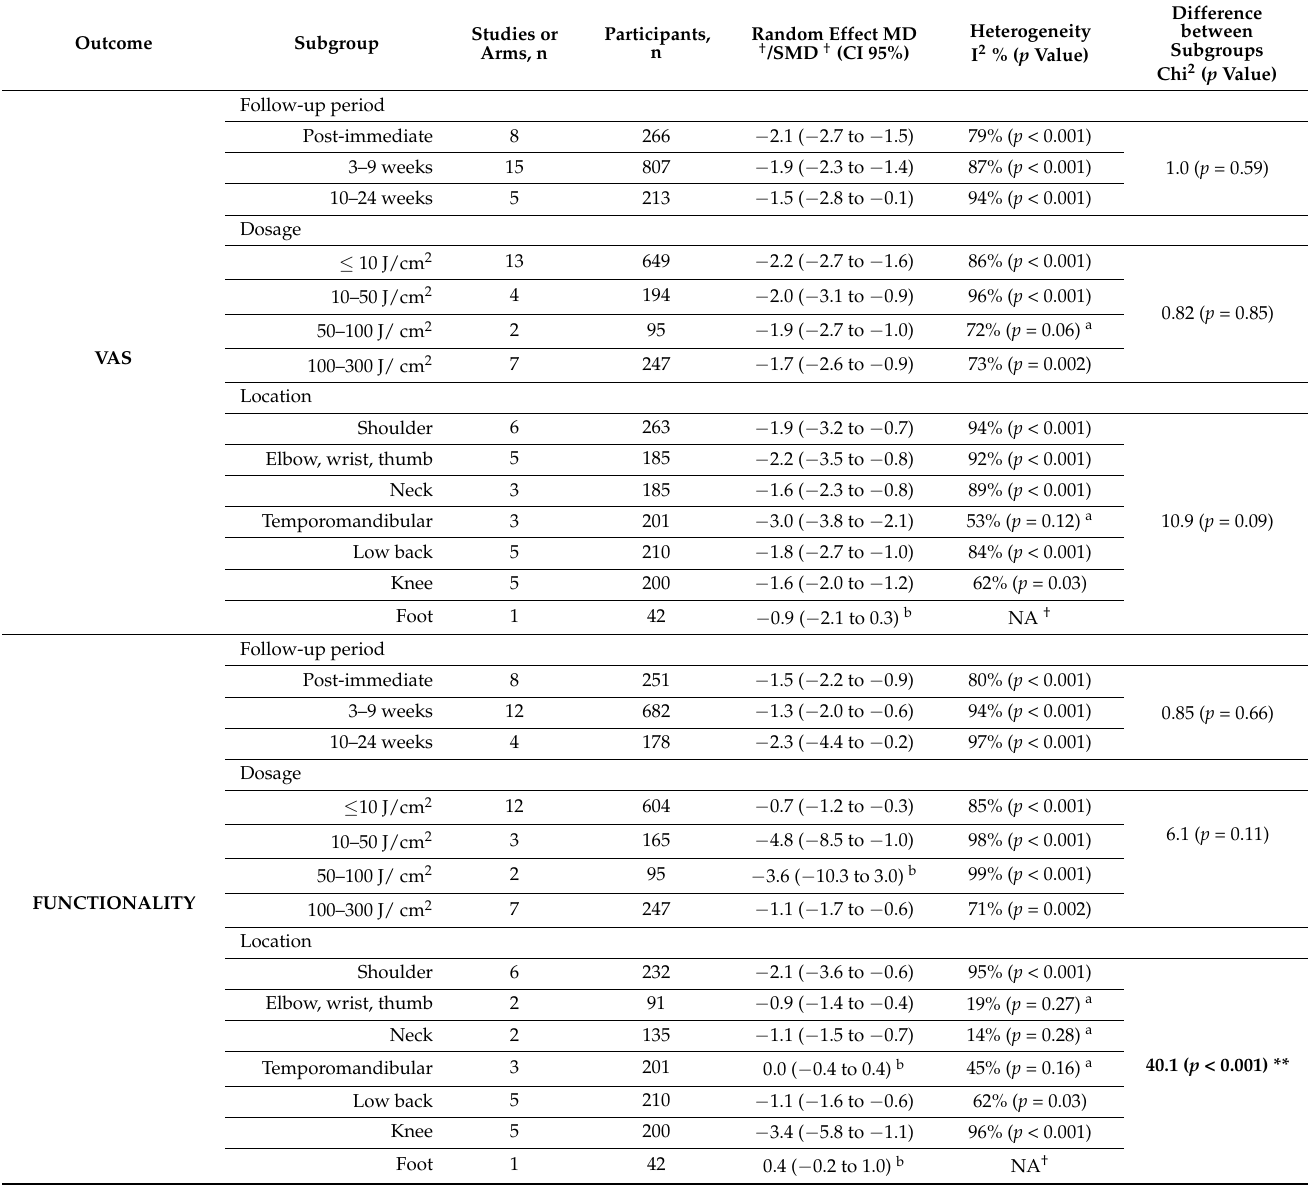
Table 1. Subgroup analysis of high-intensity laser therapy (HILT) versus control for the treatment of musculoskeletal pain, as measured on the pain VAS and